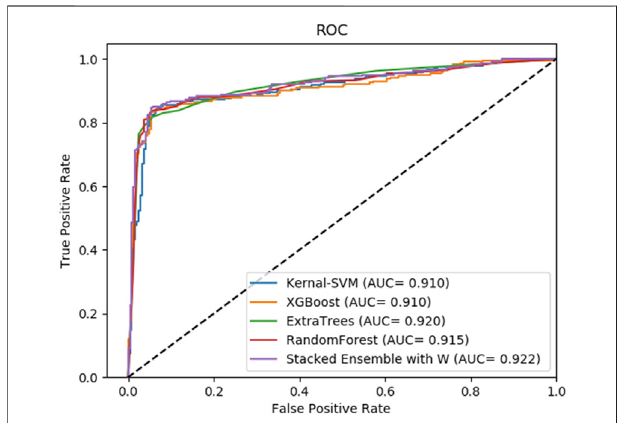
FIGURE 5 | Average result of ROC curves of fi ve-fold cross-validation with four single base classi fi ers and our method of stacking ensemble on RPI488 by SAWRPI. AUC expresses area under an ROC curve.